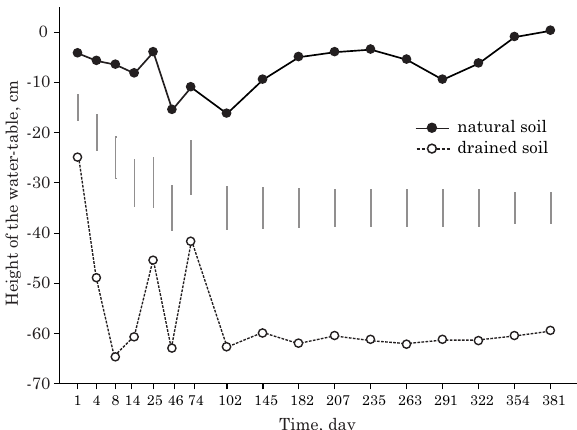
Figure 3. Groundwater table in natural and drained Histosols with waterlogged grassland vegetation. Vertical bars represent the least significant difference by Tukey’s test